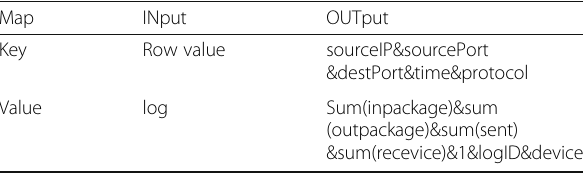
Table 1 Manages the Map phase input output for the configuration class log